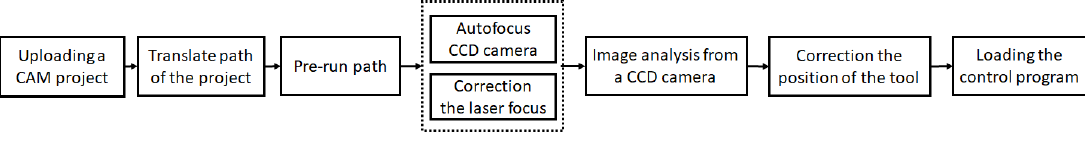
Figure 4. Scheme of the sequence of operations of the system for correcting the points of the planned trajectory in the preprocessing of laser welding using computer vision systems.